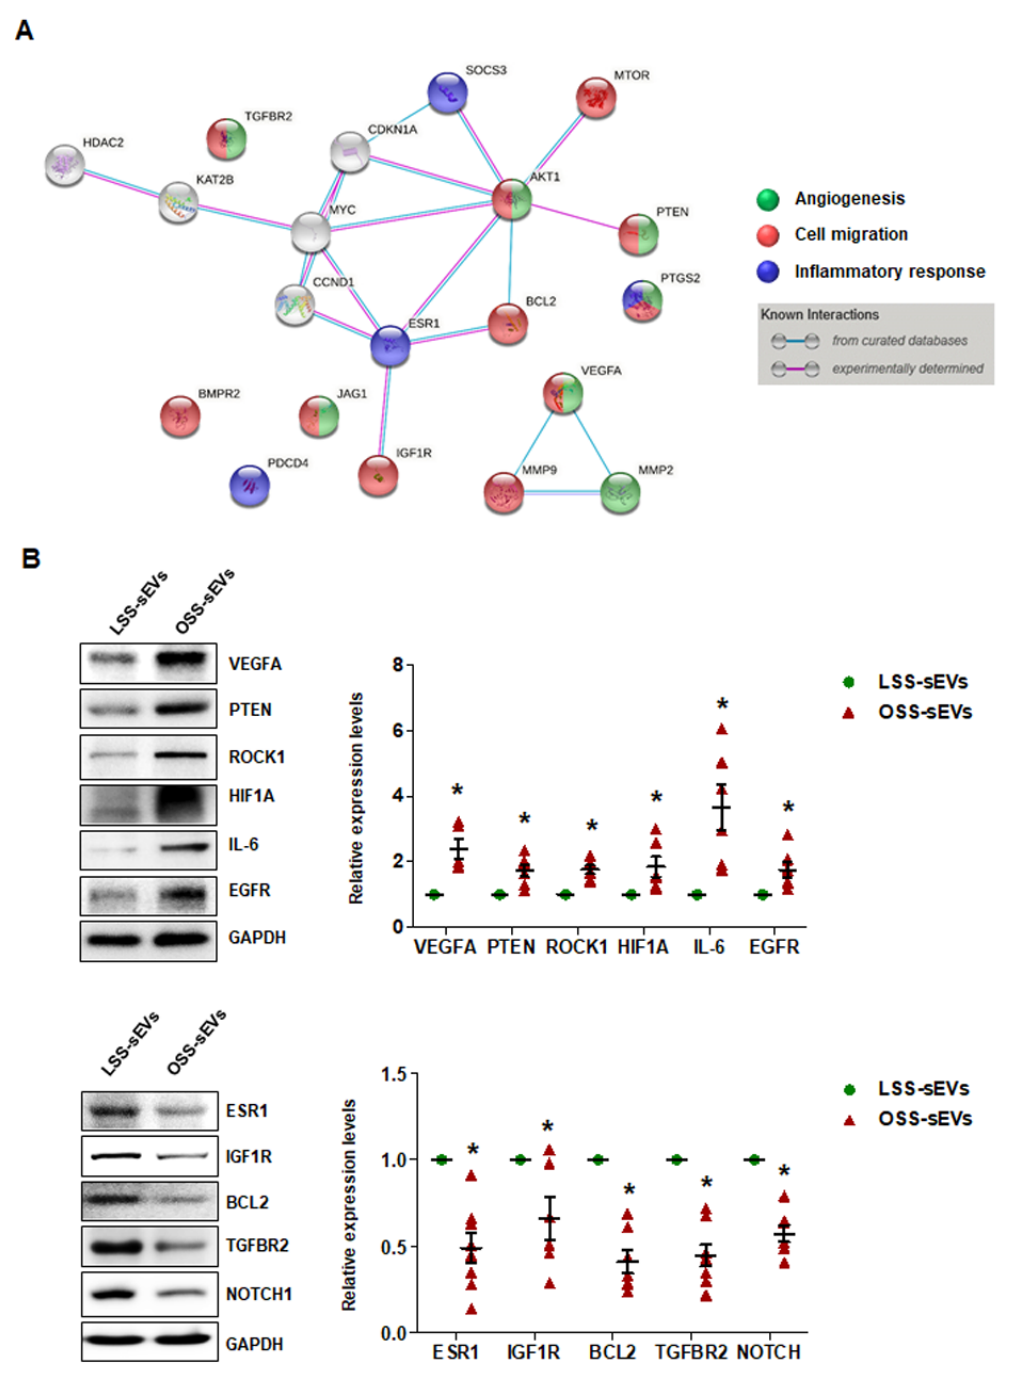
Figure 6. Identification of target proteins regulated by the miRNA landscape of shear stress-induced EC-sEVs. ( A ) Protein–protein interaction network obtained using STRING software in shear stress- induced EC-sEVs to experimentally identify important protein nodes in predicted target proteins. ( B ) HUVECs were treated with LSS- or OSS-sEVs (3 × 10 9 particles) for 24 h. The protein levels of VEGFA, PTEN, ROCK1, HIF1A, IL-6, EGFR, ESR1, IGF1R, BCL2, TGFBR2, and NOTCH1 were determined by Western blotting. The protein expression levels were normalized to GAPDH (internal control). Representative images from at least five experiments are shown ( n = 5; * p < 0.05 compared to LSS-sEVs). Mean ± SEM. Statistical analysis was performed using the nonparametric Mann–Whitney U test.